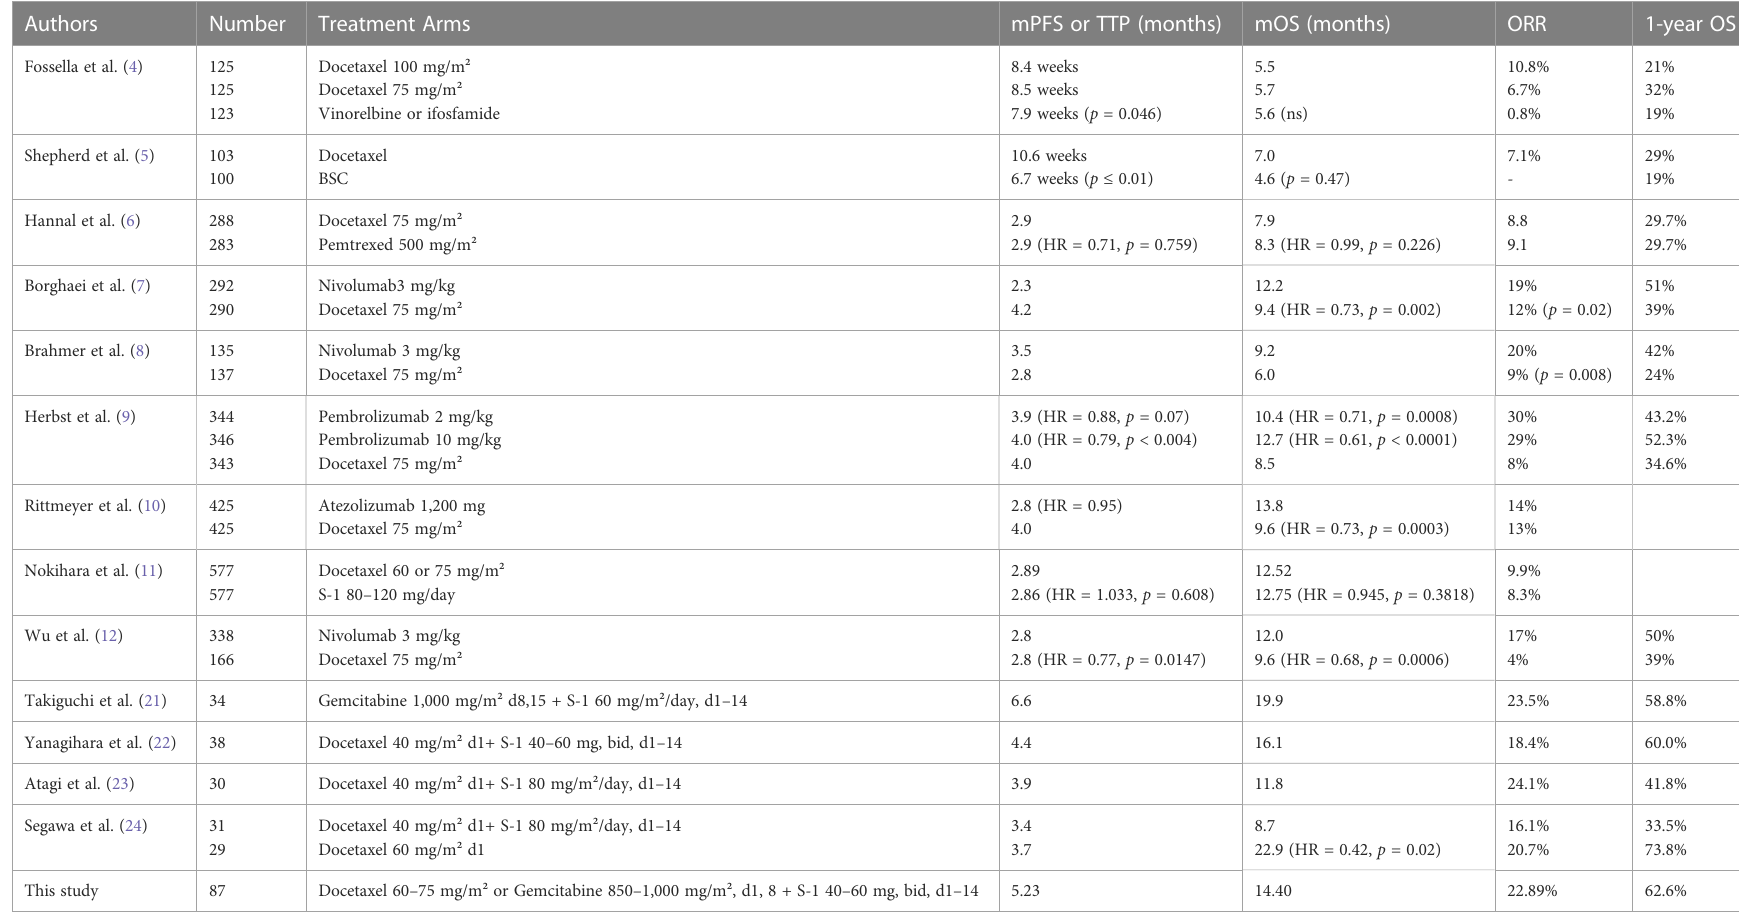
TABLE 1 Comparison of S-1-based doublet chemotherapy with docetaxel from phase III randomized controlled clinical trials of second-line treatment for advanced